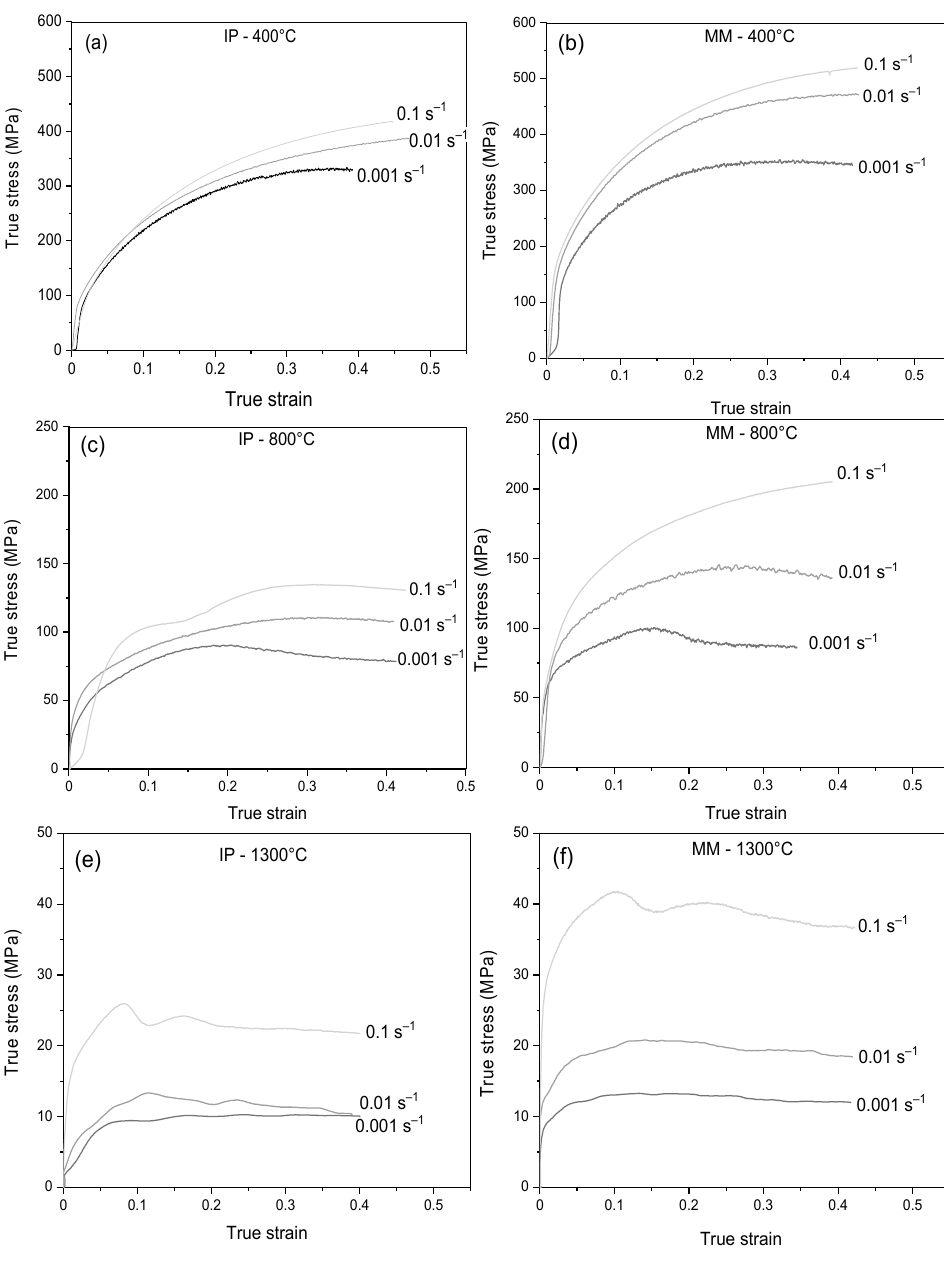
Figure 3. True stress-true strain curves of IP and MM at different temperatures. ( a ) IP 400 °C; ( b ) MM 400 °C; ( c ) IP 800 °C; ( d ) MM 800 °C; ( e ) IP 1300 °C; ( f ) MM 1300 °C .